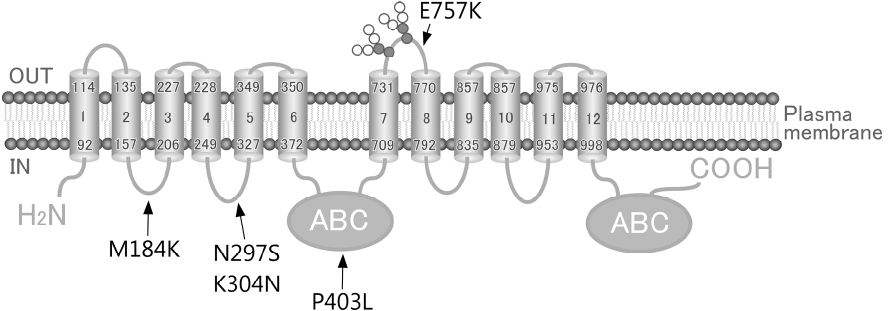
Figure 1. Schematic illustration of human ABCC4 and the location of its single-nucleotide polymorphisms (SNPs). Arrows, location of SNPs; ABC, ATP binding cassette (nucleotide binding domain).